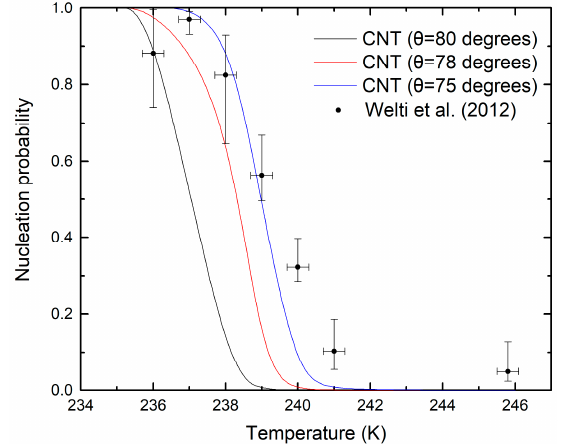
Figure 3. IN nucleation probability per surface area versus temperature for kaolinite dust using the classical nucleation theory with different contact angles and comparison with the laboratory data of Welti et al. [31].